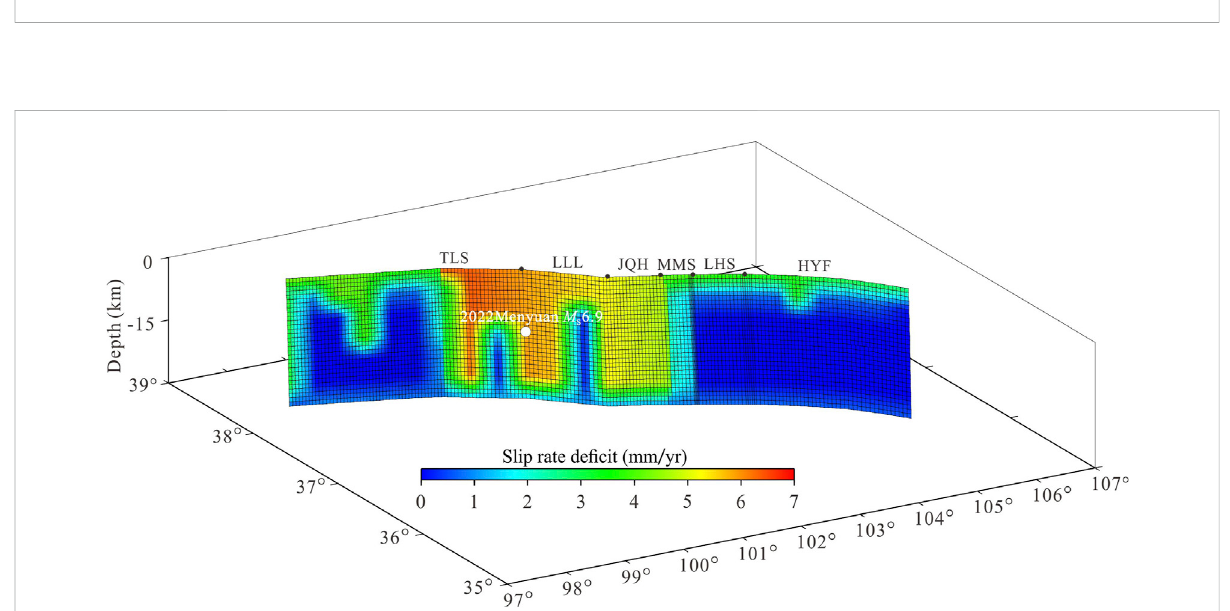
FIGURE 6 Slipratede fi citoftheQilian – Haiyuan fault zone.Hypocenterparameterswereobtained from Global CMTCatalog (http://www.globalcmt.org/ CMTsearch.html). TLSF: Tuolaishan fault; LLLF: Lenglongling fault; JQHF: Jinqianghe fault; MMSF: Maomaoshan fault; LHSF: Laohushan fault; HYF: Haiyuan